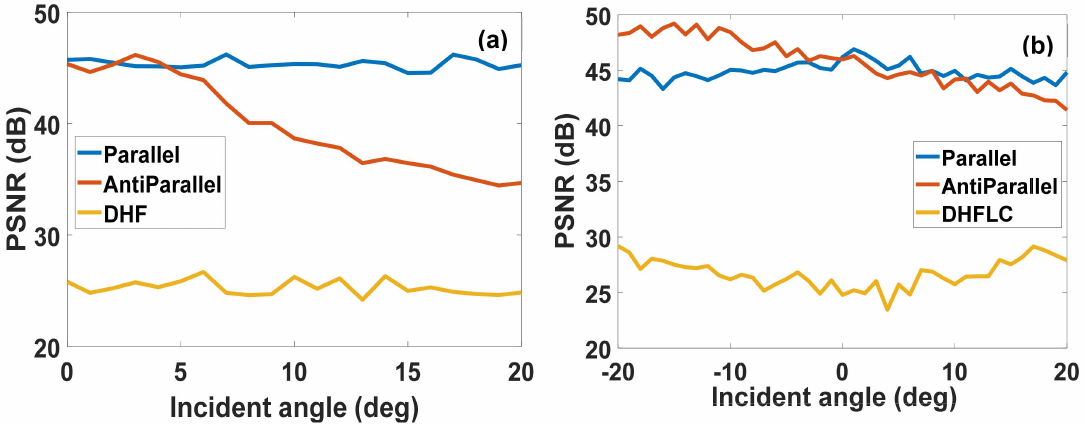
Figure 17. Reconstruction quality measured in terms of PSNR versus the incidence angle: ( a ) is for cone of light; ( b ) is for off-axis collimated